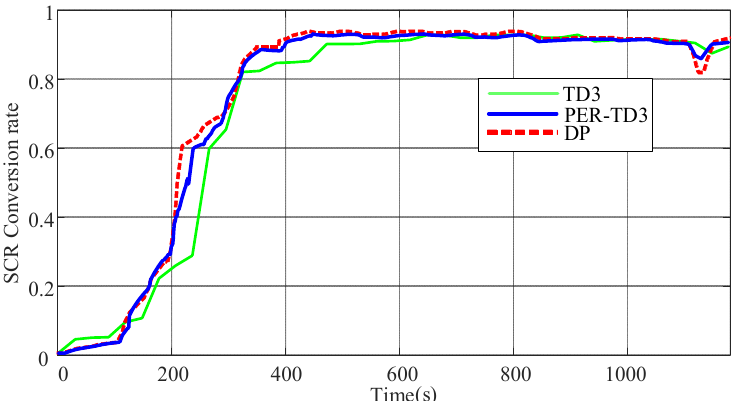
Figure 14. SCR catalytic efficiency of different Figure 14 . SCR catalytic efficiency of different strategies.